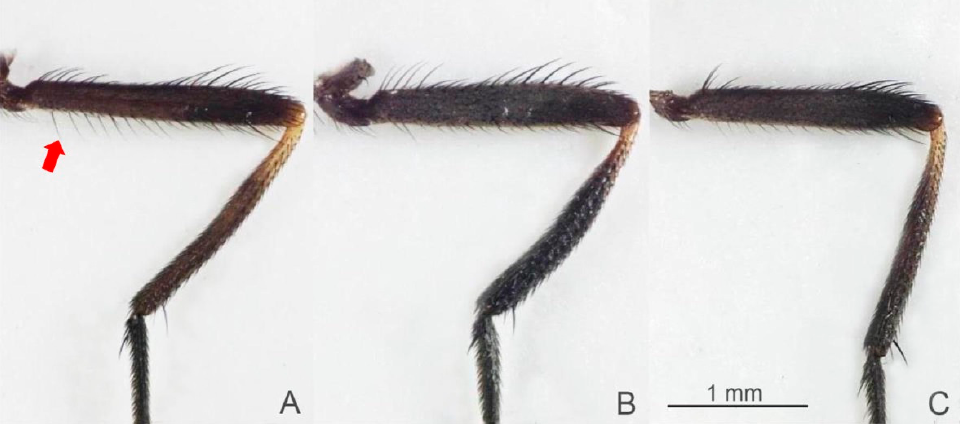
Figure 4. Male hind legs of Stomoxys bengalensis ( A ), S. calcitrans ( B ), and S. sitiens ( C ). Male S. ben- galensis is distinguished from male S. sitiens by the hind femur with long ventral hairs (arrow). Pho- tos are made by authors.